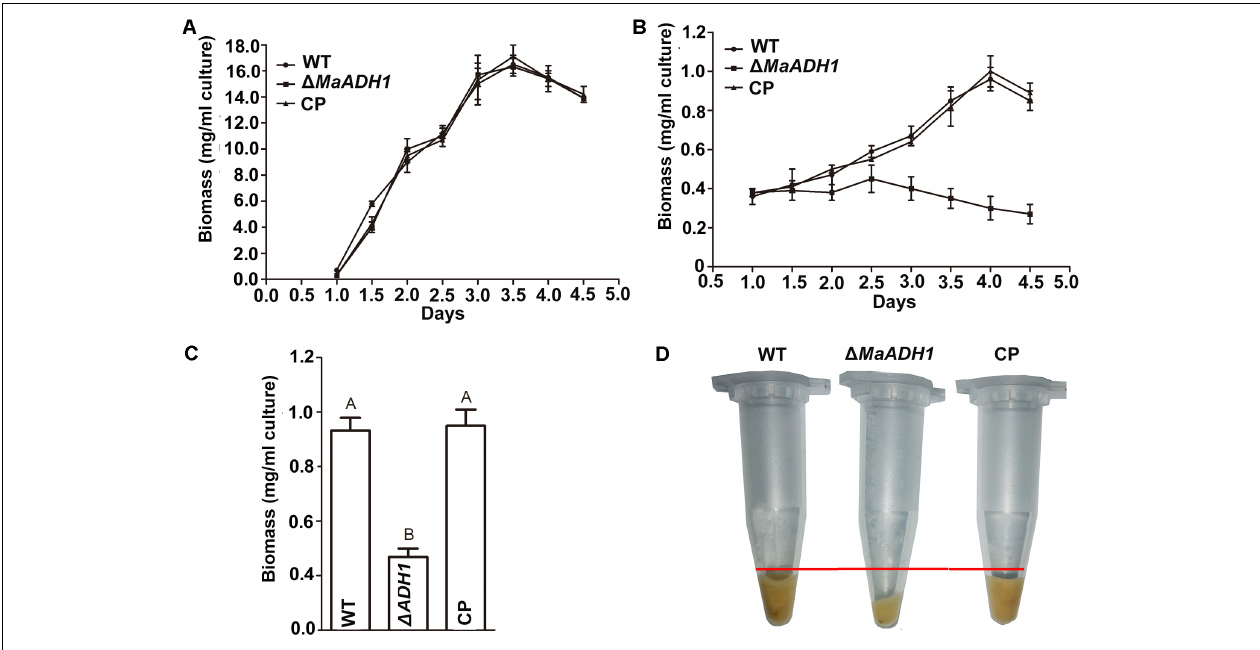
FIGURE 3 | Biomass analysis. (A) Time course study of dry weight under normal oxygen condition. (B) Biomass under low dissolved-oxygen condition. Dry weight (C) and pellets (D) on 3rd day under low dissolved-oxygen condition. Error bars are standard deviations of three trials. A, B indicate significant difference at p < 0.01.